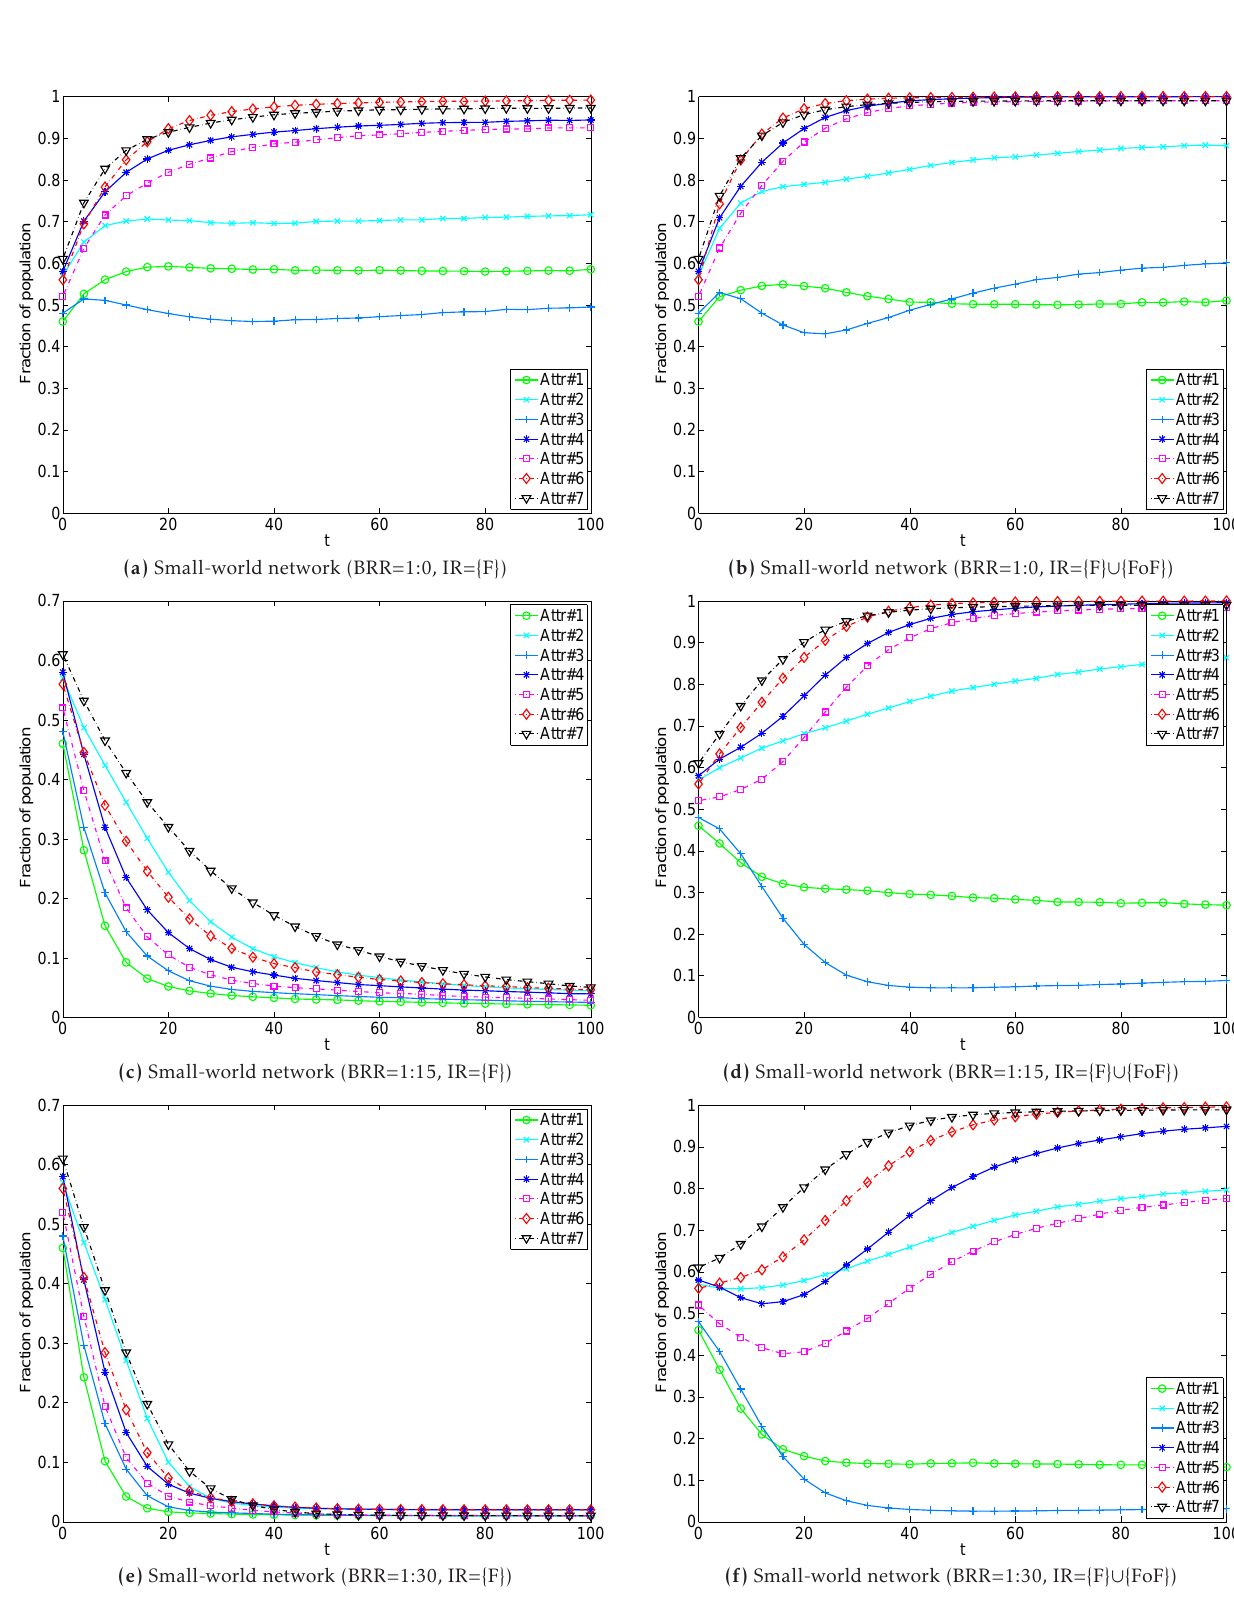
Figure 7. Attribute dynamics for the weighted evolutionary game in small-world network. The figures in left column correspond to applying Friends as the influential range of the utility